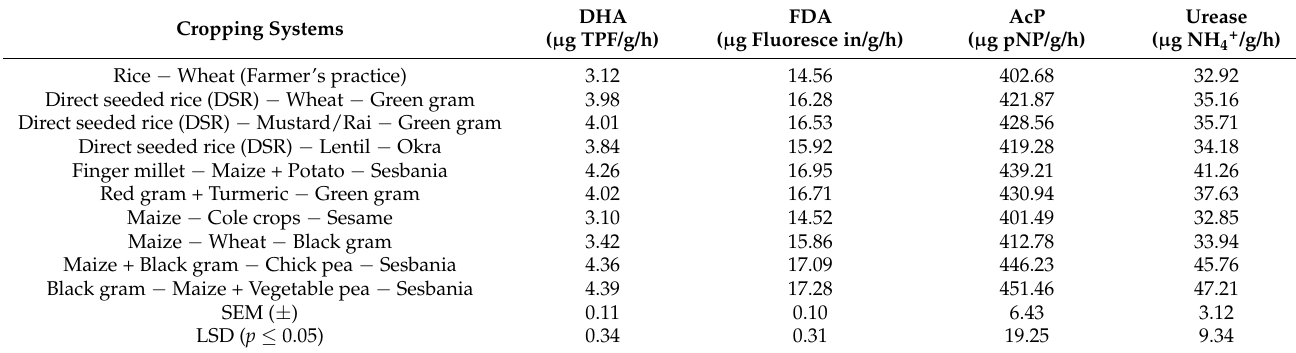
Table 10. Soil enzymes are influenced by a diversified cropping